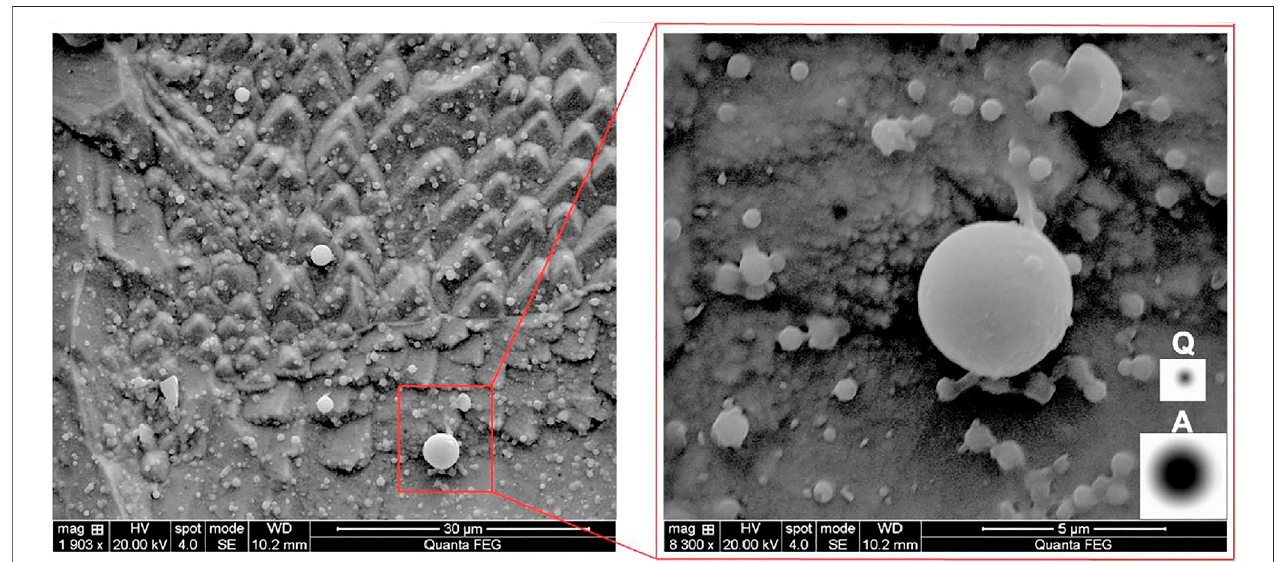
FIGURE10| Secondaryelectron micrographofsampletaken1 minuteaftercalciumtreatment inExperimentB,deep-etchedtoshowsmallinclusions.Thecircles below the symbols “ A ” and “ Q ” are simulated backscattered electron micrographs of inclusions at the surface of polished samples, representing the spatial resolution in the ASPEX SEM ( “ A ” ) and Quanta 600 ( “ Q ” ).